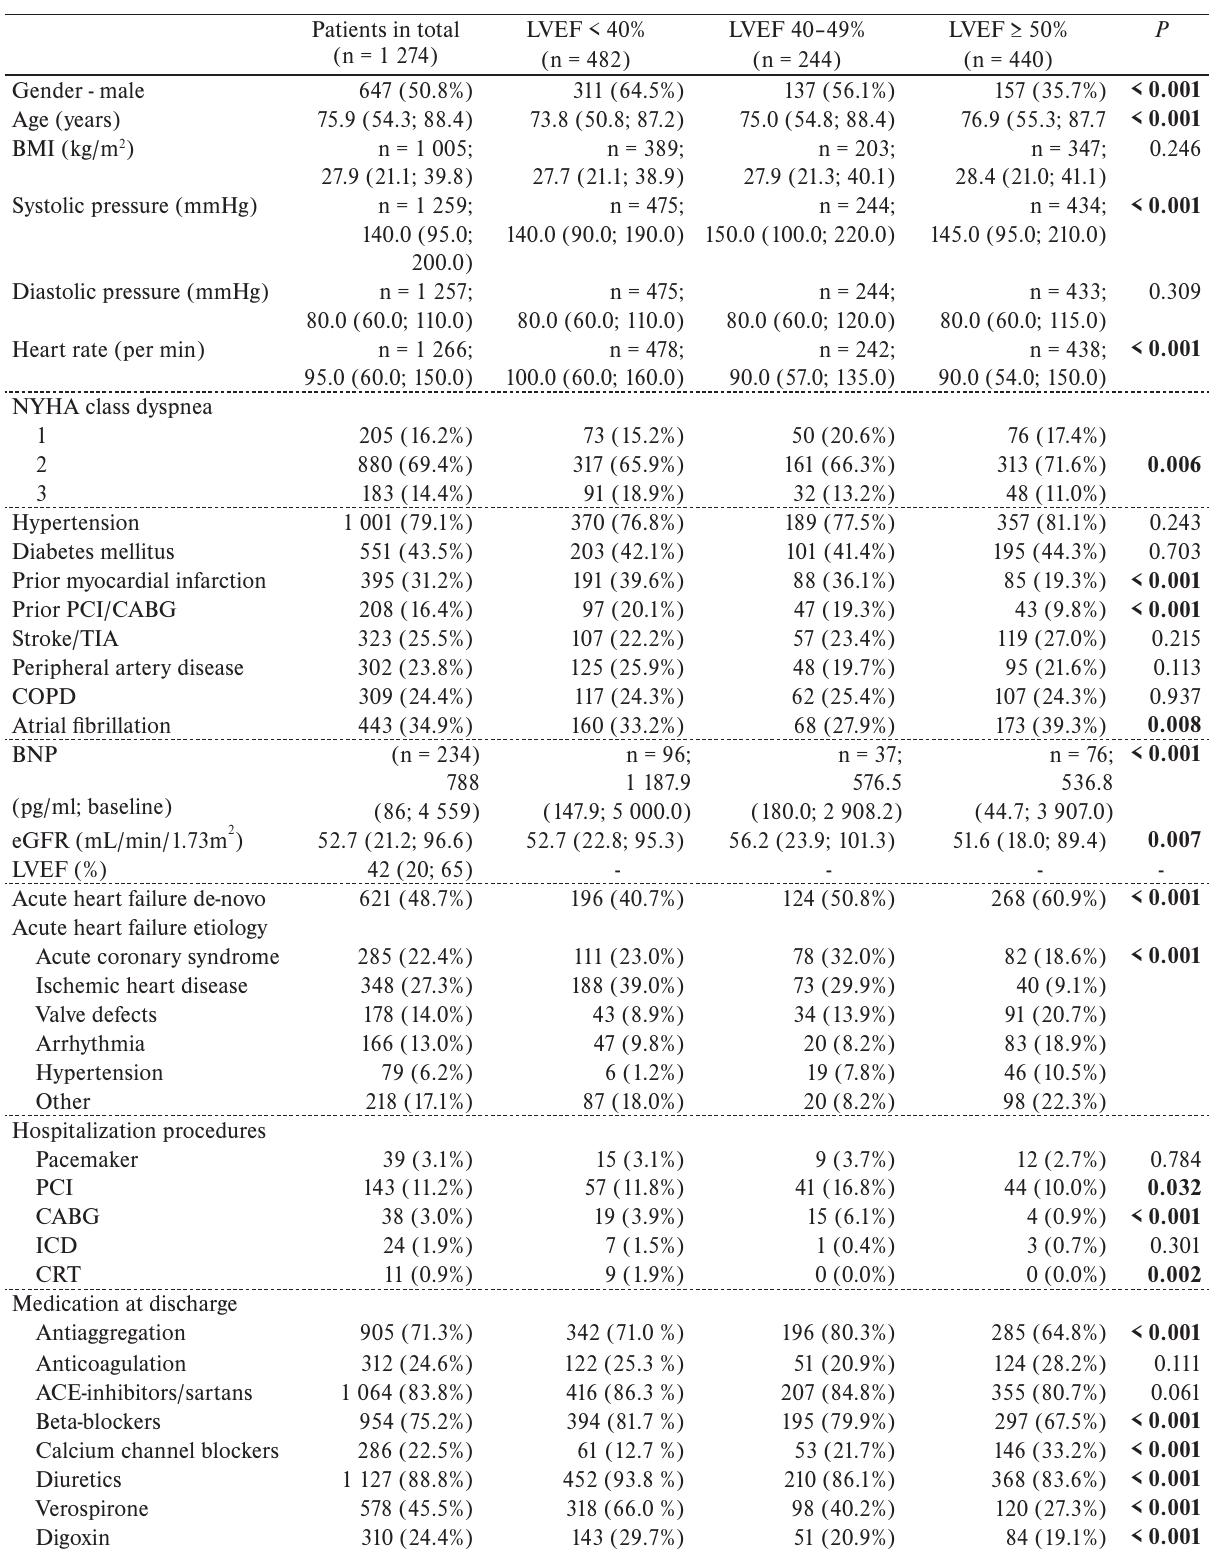
Table 1. Basic characteristics of 1274 consecutive patients discharged from hospitalization for acute heart failure in a stabilized condition. A total of 1166 (91.5%) patients had echocardiography performed during index